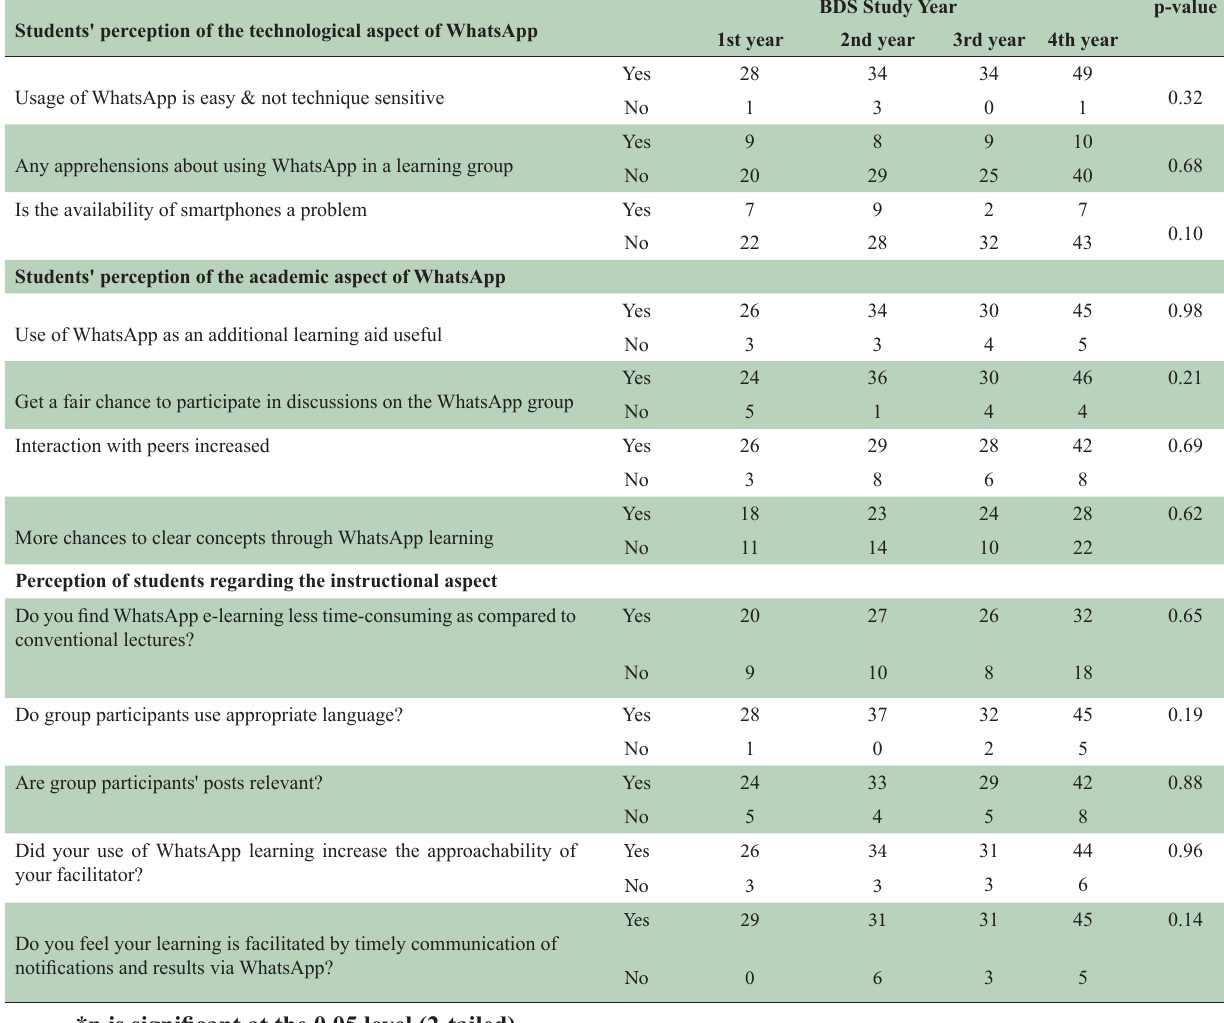
Table-IV: Association between the technical, academic, and instructional aspects of WhatsApp with study years of BDS students.